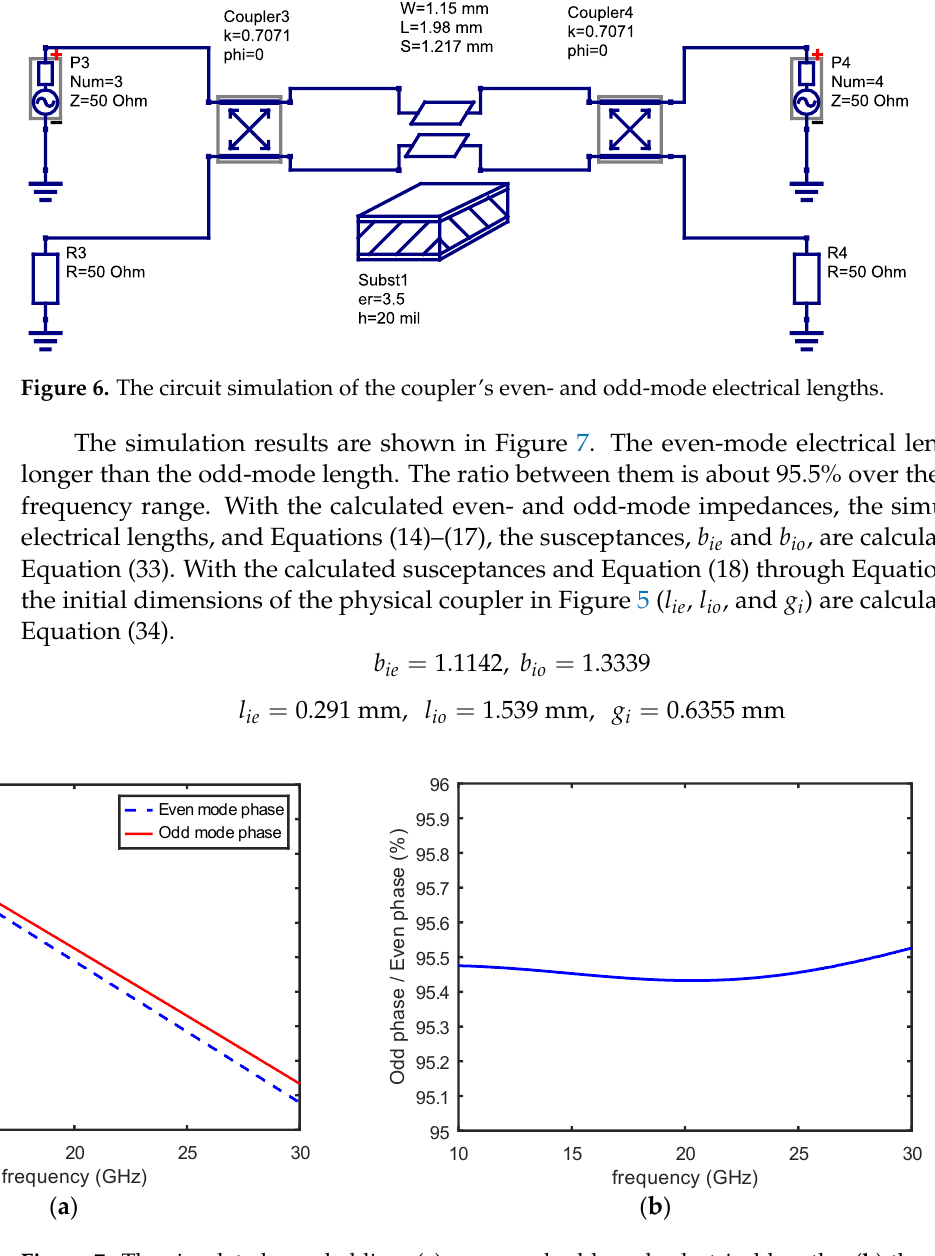
Figure 7. The simulated coupled line: ( a ) even- and odd-mode electrical lengths; ( b ) the ratio of even-mode and odd-mode electrical lengths.